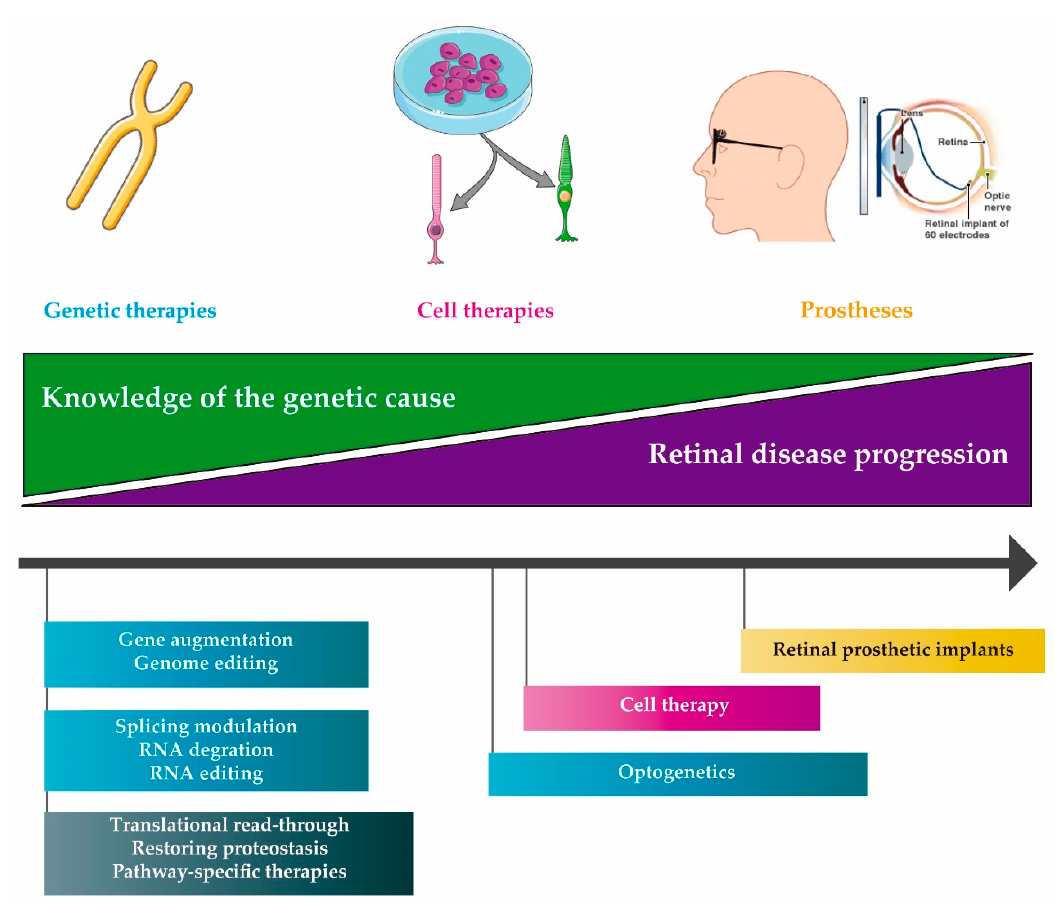
Figure 1. Schematic representation of potential therapeutic approaches according to the retinal disease